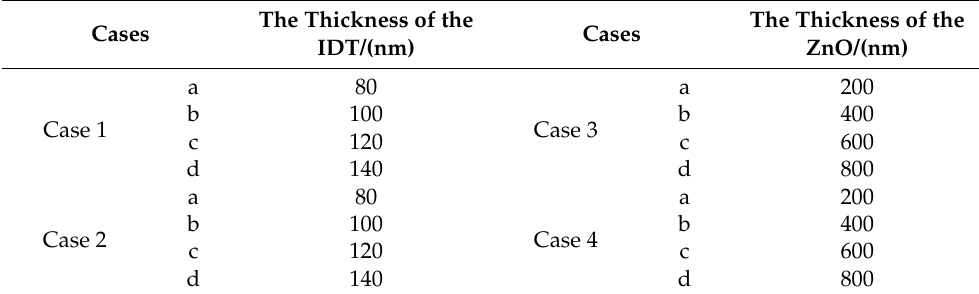
Table 3. Optimized parameters of the IDT electrode size and the ZnO layer’s